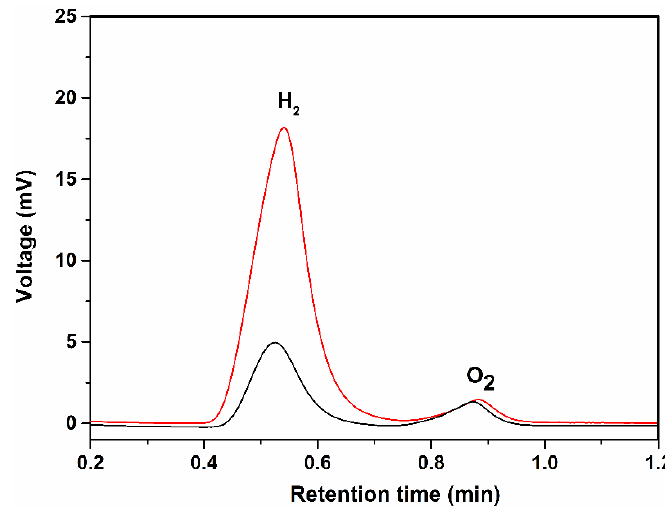
Figure 4. Gas chromatography (GC) analysis of the sample gas (500 µL) from the headspace of the photoelectrochemical (PEC) cell for planar silicon (black trace) and SiNW (red trace) coated with Fe 2 S 2 (CO) 6 catalyst, respectively.